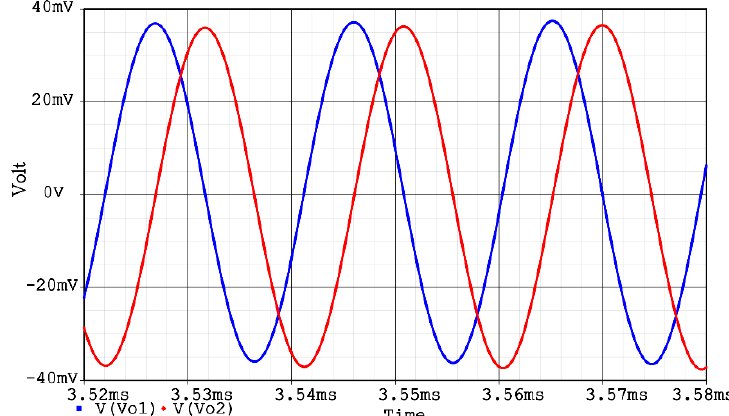
Figure 24. Simulated steady state waveform of the VM quadrature V o1 (blue) and V o2 (red) voltage outputs.